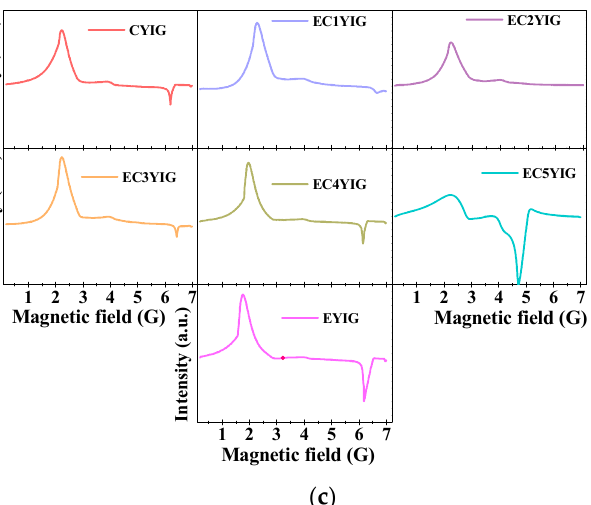
Figure 5. Structural features and valence states of spent yttrium iron garnet ferrites by ( a , b ) XRD and ( c ) EPR measurements. The included figure in the XRD is the structure of YIG. Reaction conditions: EB to H 2 O 2 molar ratio of 1 using 1.3 mol of acetone as solvent, temperature of 50 °C and a catalyst mass of 50 mg within 360 min of reaction.